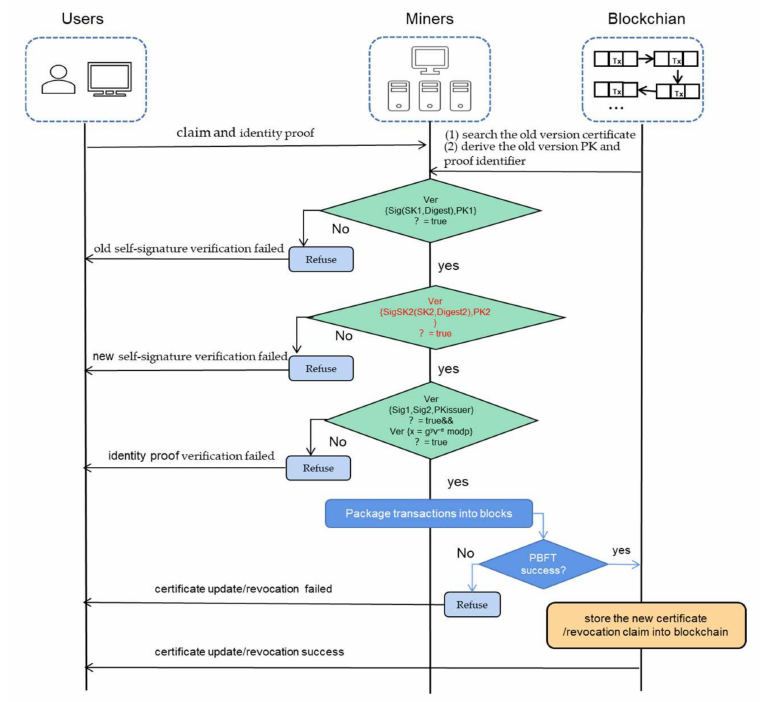
Figure 5. The verification process of updating and revoking claims.